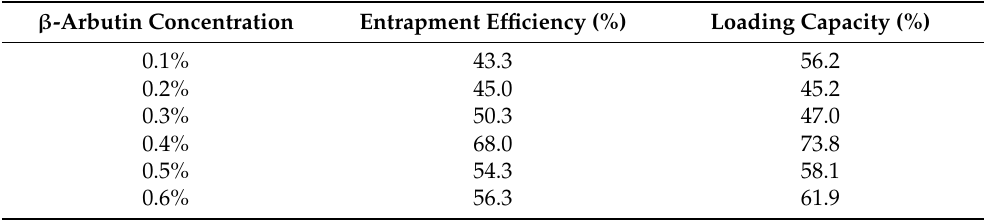
Table 1. Entrapment efficiency and drug loading capacity of β -arbutin